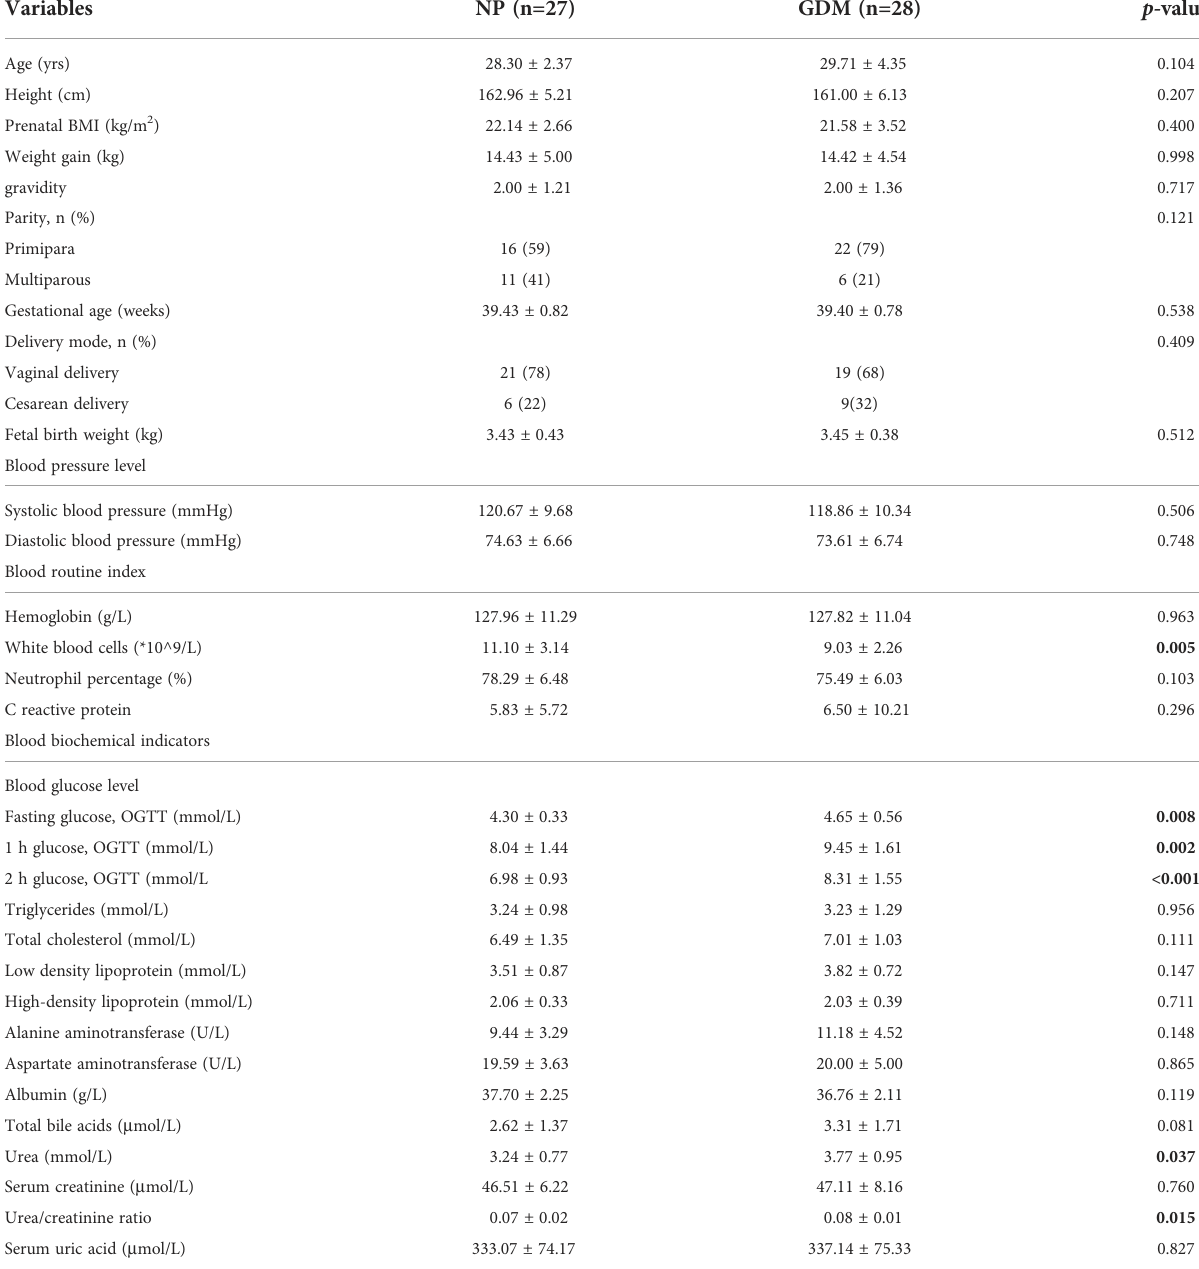
TABLE 1 Maternal and fetal clinical characteristics in the GDM and NP